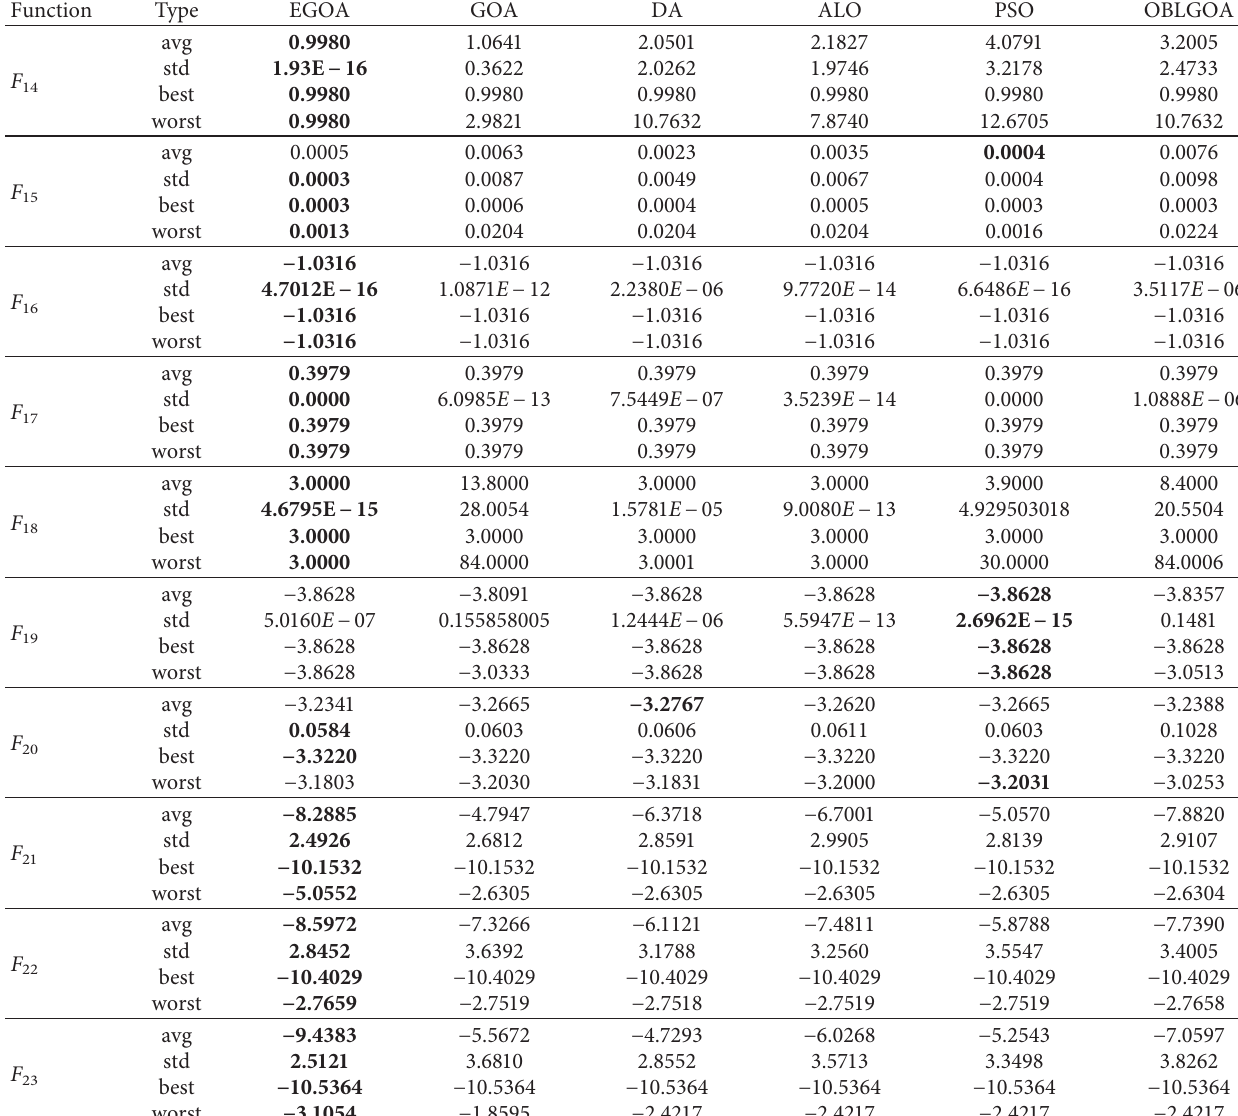
Table 6: Results for fixed-dimension multimodal